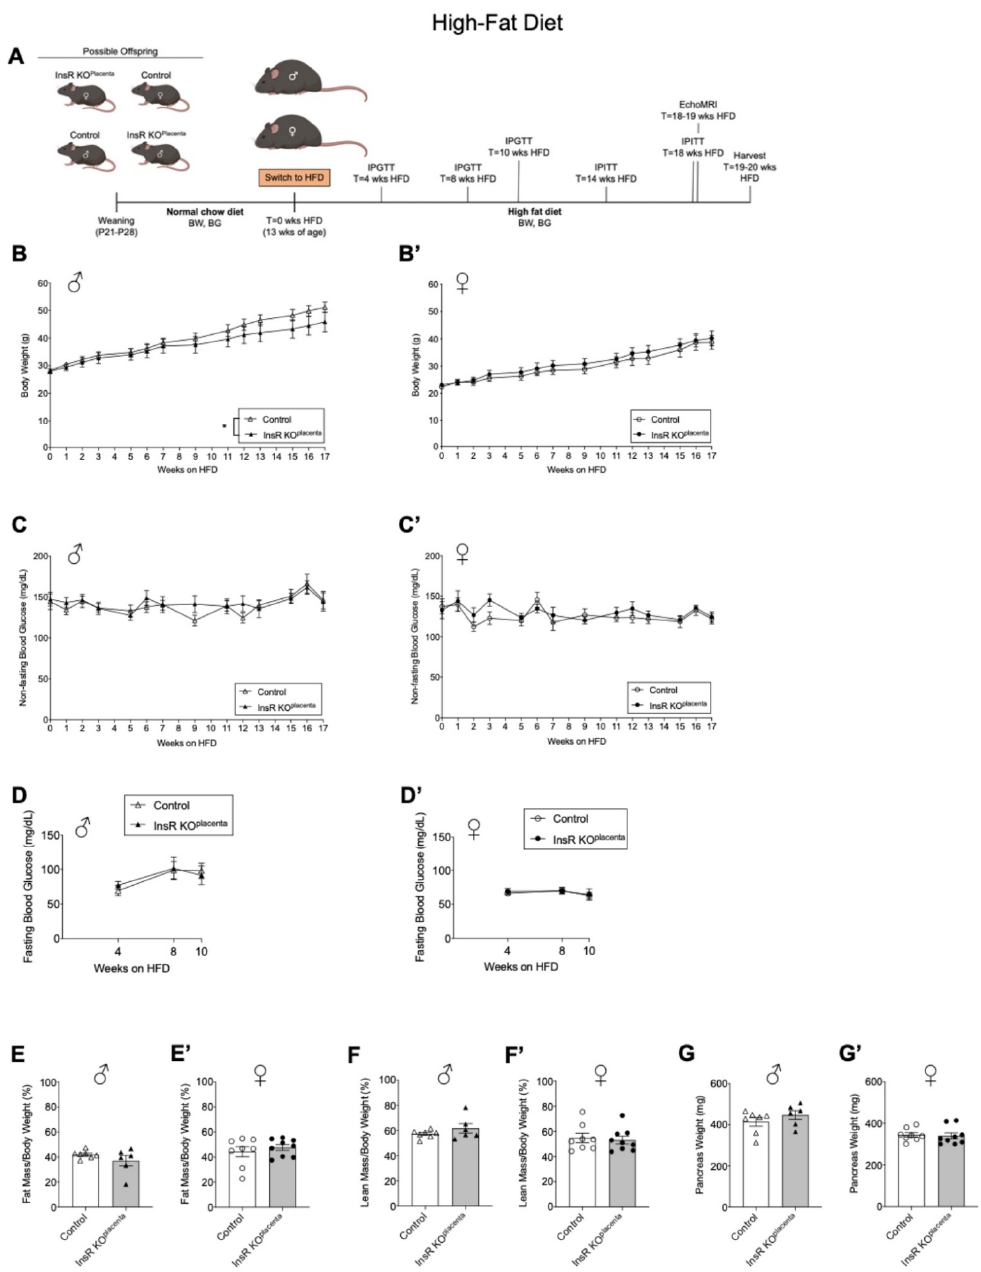
Figure 3. Adult male InsR KO placenta offspring demonstrated lower body weight under a high-fat diet challenge. ( A ) Schematic of experimental design for a high-fat diet (HFD). ( B ) Body weight monitored in all the males ( n = 6, 7) and ( B’ ) females ( n = 8, 9) from parity ≥ 3 and ≤ 2 across 17 weeks on a HFD. ( C ) Non-fasting blood glucose levels for all the males ( n = 6, 7) and ( C’ ) females ( n = 8, 9) from parity was ≥ 3 and ≤ 2 (measured across 17 weeks on a HFD). Measurements not included for T = 4, 8, 10, 14, and 18 weeks on a HFD due to phenotyping performed on these weeks. ( D ) Fasting blood glucose measured for the males ( n = 4, 7) and ( D’ ) females ( n = 4, 9) from parity ≥ 3 and ≤ 2 at 4, 8, and 10 weeks on a HFD. ( E ) Fat mass for the males ( n = 6, 7) and ( E’ ) females ( n = 8, 9) from parity ≥ 3 and ≤ 2 as assessed by EchoMRI at 18–19 weeks on a HFD. ( F ) Lean mass for the males ( n = 6, 7) and ( F’ ) females ( n = 8, 9) from parity ≥ 3 and ≤ 2 as assessed by EchoMRI at 18–19 weeks on a HFD. ( G ) Pancreas weight for the males ( n = 6, 7) and ( G’ ) females ( n = 8, 9) from parity ≥ 3 and ≤ 2 upon harvest at 19–20 weeks on a HFD. The values are reported as the means ± SEM, * p < 0.05. P: postnatal; BW: body weight; BG: blood glucose; IPGTT: intraperitoneal glucose tolerance test; IPITT; intraperitoneal insulin tolerance test; HFD: high-fat